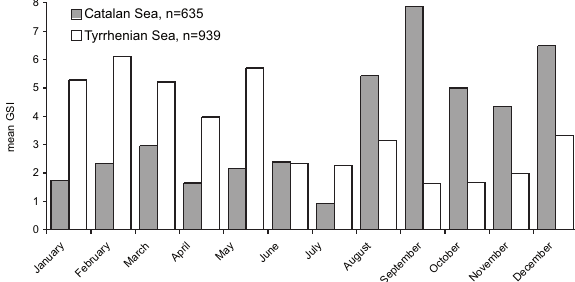
Fig . 6. – Monthly seasonal variation of female gonadosomatic index